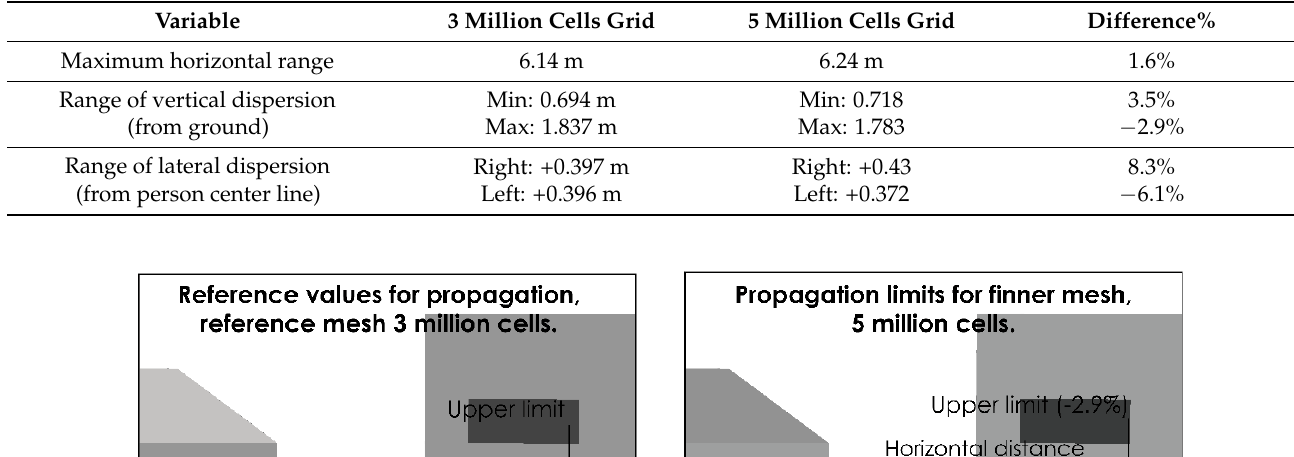
Table 3. Grid convergence analysis.